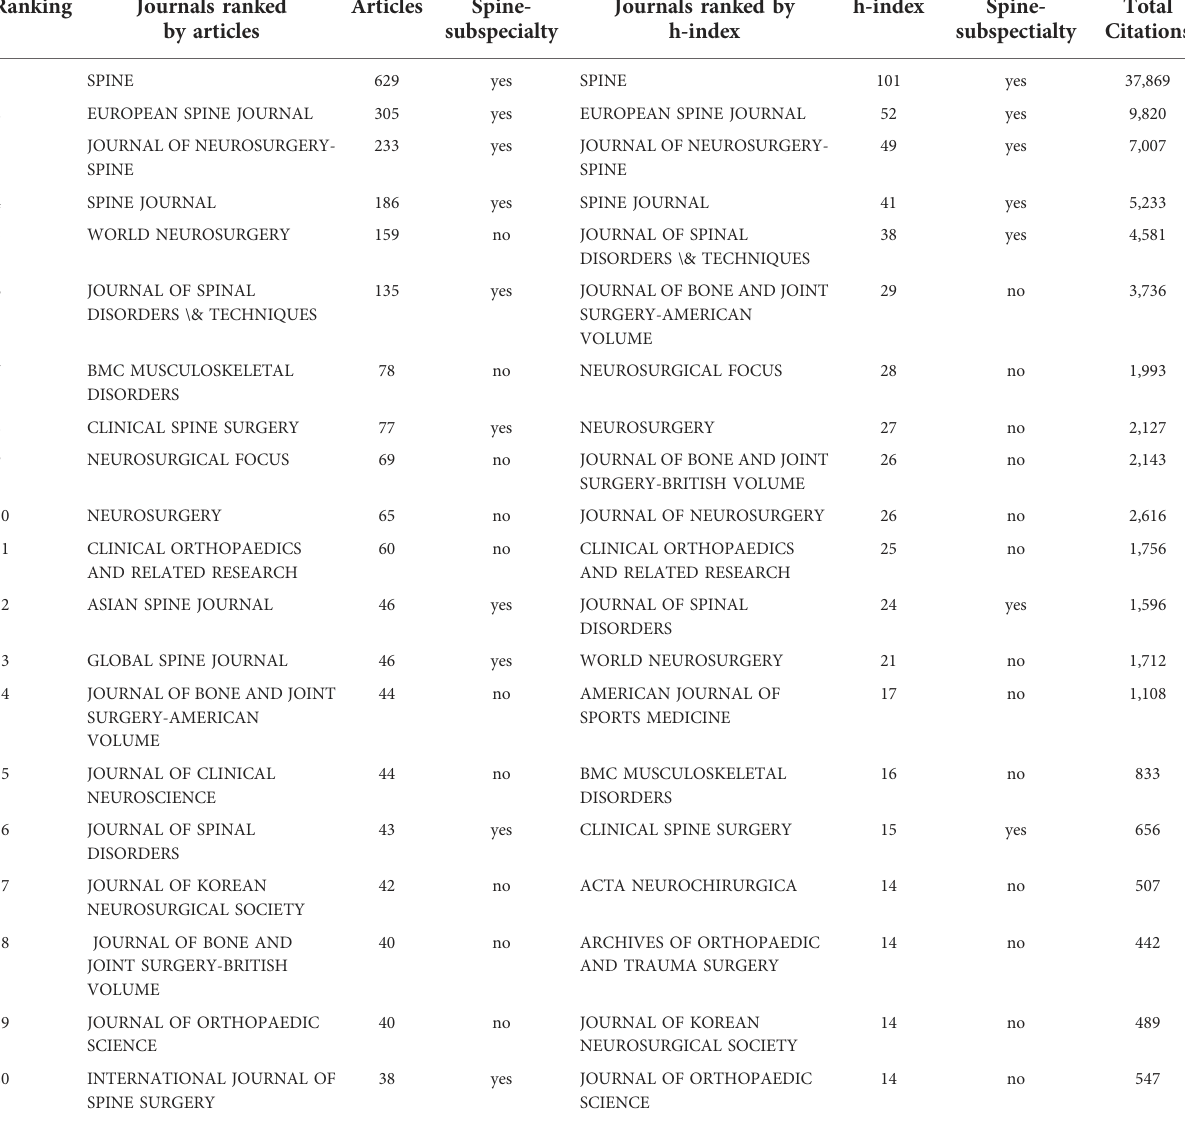
TABLE 2 Top-20 productive and top-20 in fl uential journals in the fi eld of lumbar spondylolisthesis. Ranking Journals ranked by